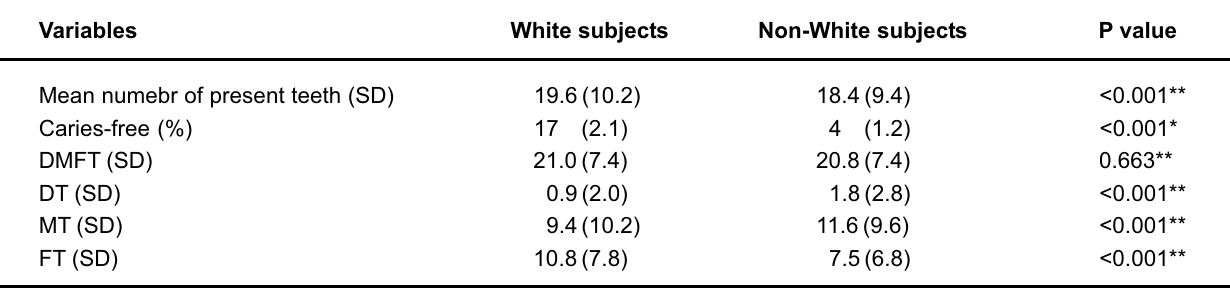
TABLE 4- Mean number of present teeth and caries experience according to the ethnic group. Southeastern state of São Paulo, Brazil